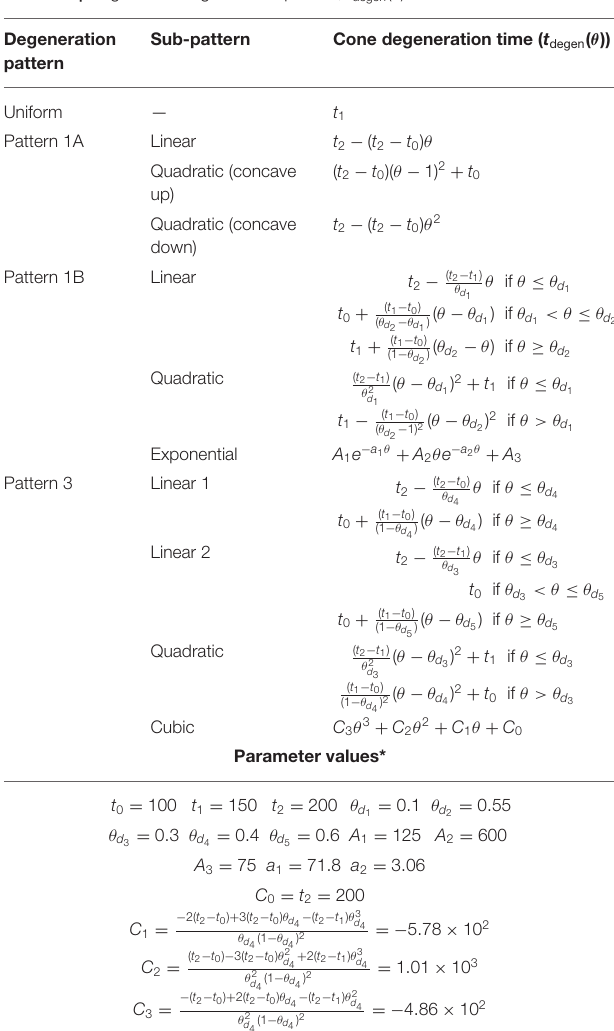
TABLE 3 | Target cone degeneration profiles, t degen ( θ